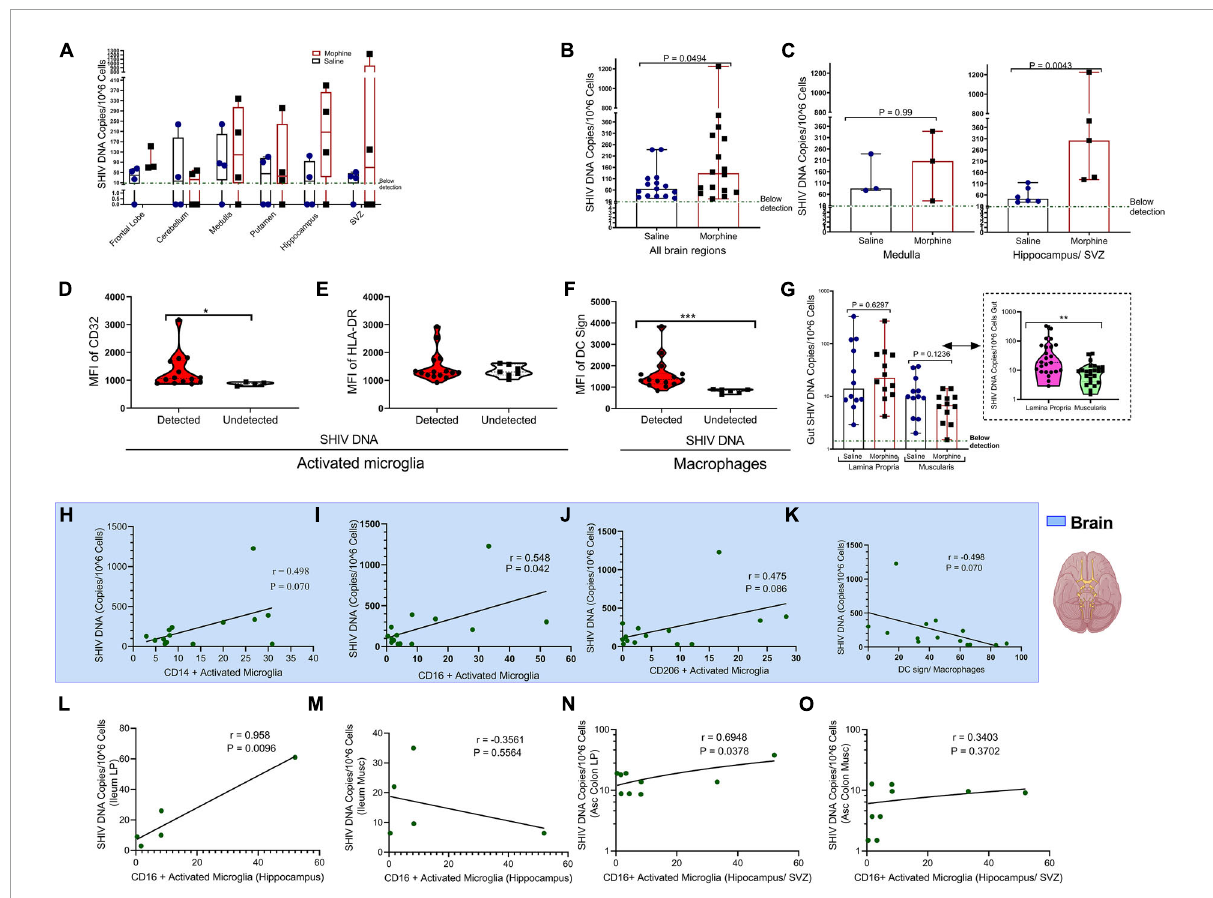
FIGURE4 Relationship between CD16+ Activated Microglia and either gut or brain simian human immunodeficiency virus (SHIV) DNA. (A) Levels of SHIV DNA within the frontal lobe, cerebellum, medulla, putamen, hippocampus, and subventricular zone (SVZ) in morphine vs. saline exposed rhesus macaques. (B) Comparison of levels of SHIV DNA pooled within all the brain regions after adjusting for regions in which the virus was not detected. (C) Levels of SHIV DNA within the brain stem (medulla) and sites of neurogenesis (hippocampus/SVZ) in morphine vs. saline-treated rhesus macaques. (D) Mean Fluorescence Intensity (MFI) of CD32 (E) HLA-DR in activated microglia and (F) DC Sign in macrophages found within niches of detected and undetected SHIV DNA across the total brain. (G) Levels of SHIV DNA within the lamina propria and muscularis mucosa with further stratification of saline and morphine groups. All data represent median ± range in Panels (A–G) . (H) Association of brain SHIV DNA with CD14+ activated microglia (I) CD16+ activated microglia (J) CD206 activated microglia, and (K) DC Sign macrophages pooled form all brain regions in which SHIV DNA was detected. (L) Association between hippocampus CD16+ activated microglia and either SHIV DNA in ileum lamina propria (LP) or (M) ileum muscularis (Musc). (N) Relationship between CD16+ activated microglia found in neurogenic sites (hippocampus/SVZ) in ascending colon (Asc Colon) LP and (O) Asc Colon Musc. (* p < 0.05, ** p < 0.01, *** p < 0.001). Mann–Whitney U -tests were used for significance in panels (B–F) . For panel (G) , multiple comparisons were evaluated using one-way ANOVA with Holm-Sidak post hoc